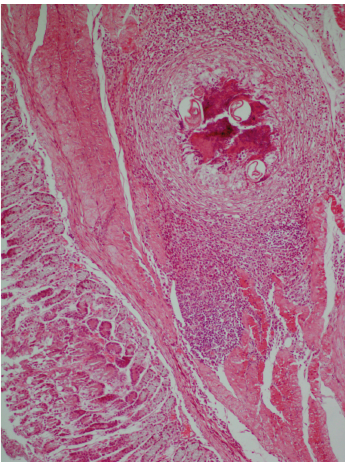
Figure 6: Sections of stomach showing an old parasitic granuloma of an unidentified larva and chronic inflammatory changes along with necrosis, fibrosis, and dystrophic calcification surrounded by a distinct fibrous encapsulation (H. E. original magnification × 100X).